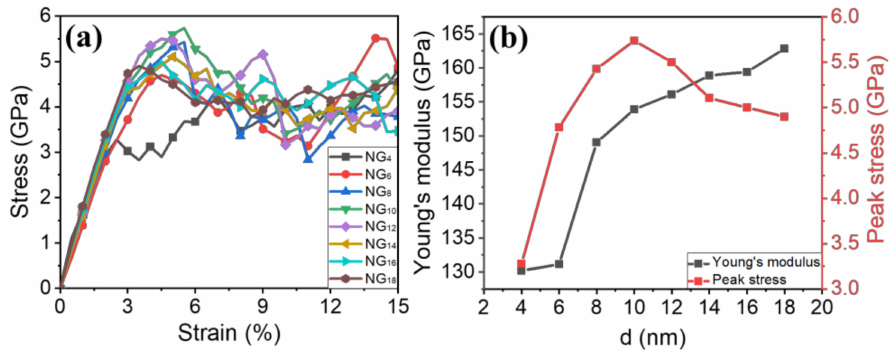
Figure 3. ( a ) Tensile stress–strain relationships of nanograined Fe cases with various grain sizes; ( b ) Young’s modulus and peak stress as a function of